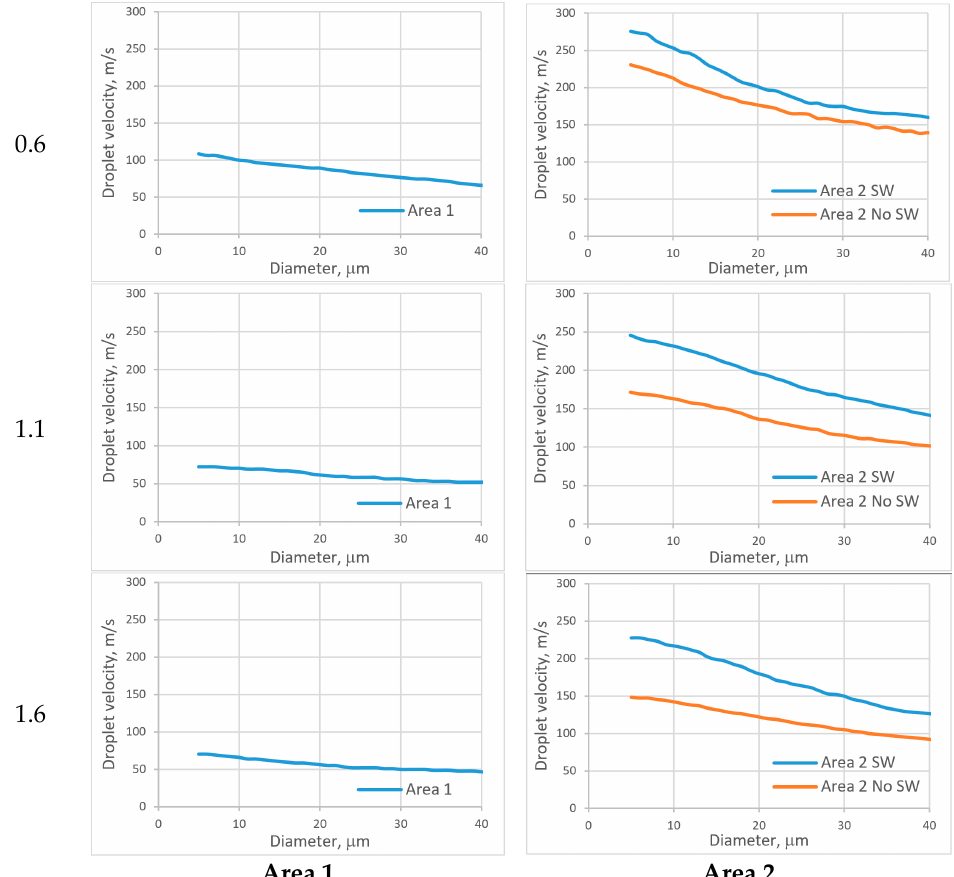
Figure A6. Velocity distribution by droplet diameters, gas flow Mach number M = 3. The left column shown water injection pressure p l , MPa